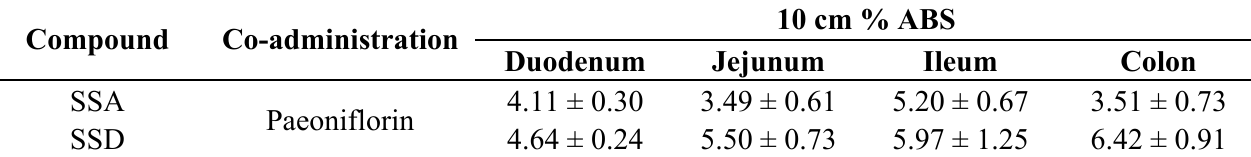
Table 4. 10 cm % ABS of paeoniflorin co-administration with SSA and SSD in different intestinal segments ( x ± s, n =